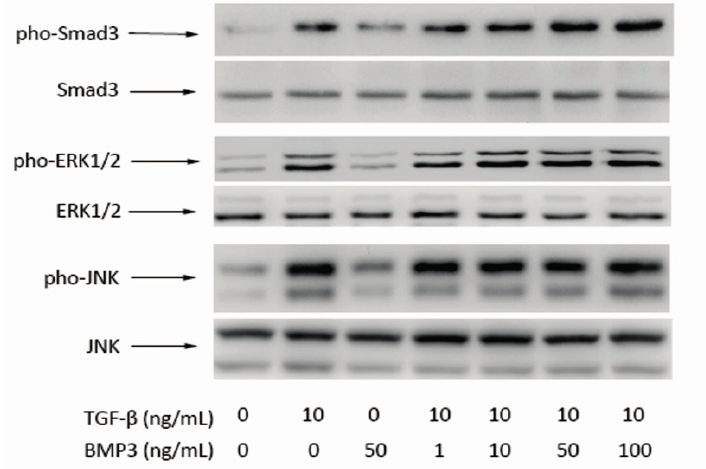
Figure 7. Western Blot of pho-Smad3/Smad3, (pho-ERK1/2)/(ERK1/2) and pho-JNK/JNK in protein extracts from each group of MSCs in beads after 4 h of